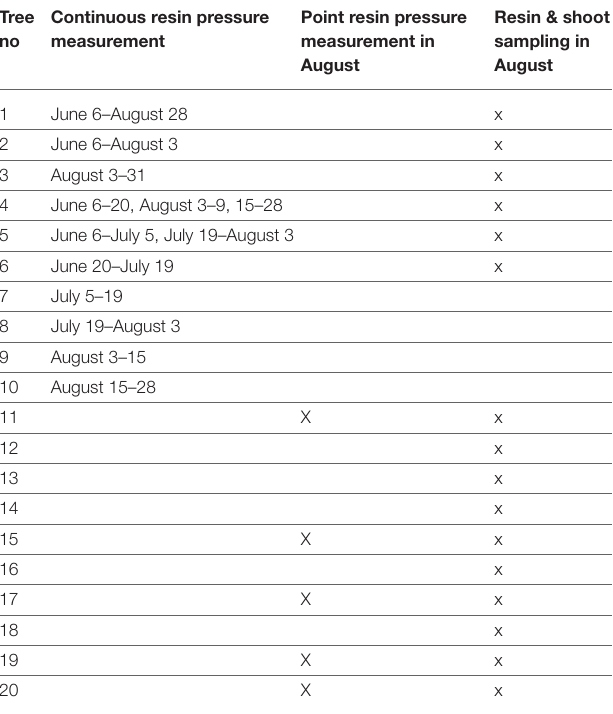
TABLE 1 | Information on which trees were used for continuous resin pressure measurement, for point resin pressure measurements and for sampling of resin and shoots for monoterpene